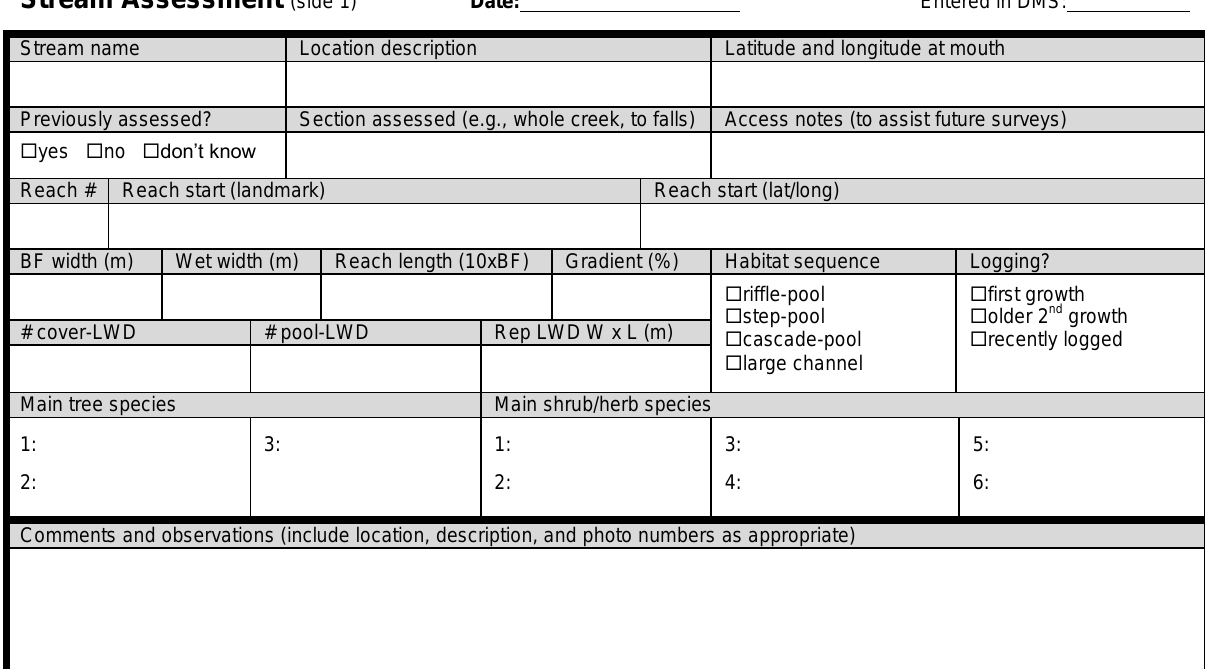
Fig. A1.2 – Side 1 of the Stream Assessment card used to record reach-level characteristics at each stream